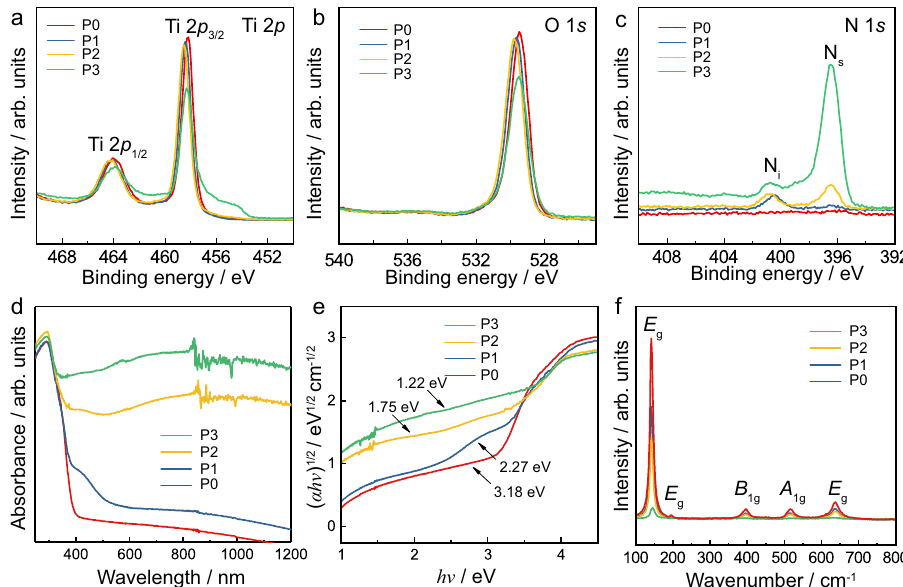
Fig. 1 Electronic properties of N-doped P25. XPS spectra of N-doped P25 TiO 2 treated with ammonia fl ow at different temperatures: ( a ) Ti 2 p , ( b ) O 1 s and ( c ) N 1 s . Photo-absorption properties characterised by ( d ) UV-vis absorption spectra, ( e ) corresponding Tauc plots and average band gaps with fi tting errors obtained, and ( f ) Raman spectra.